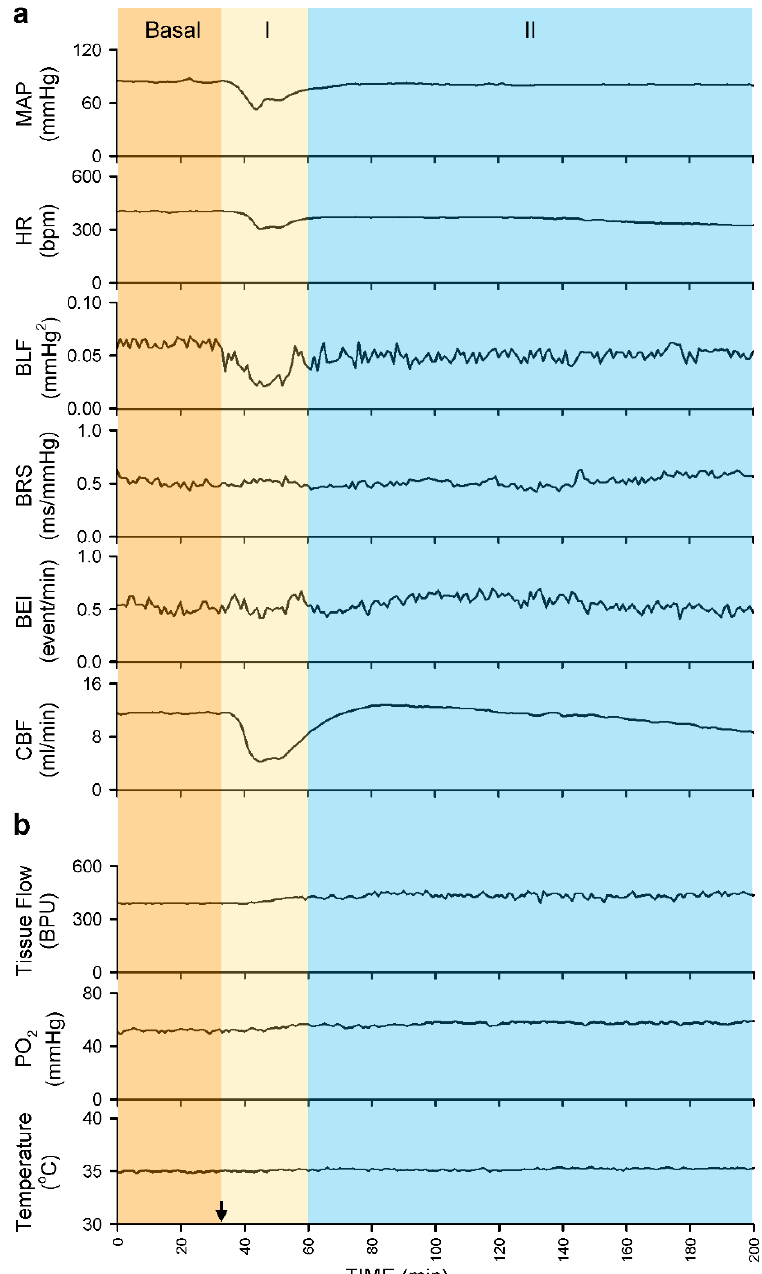
Figure 3. Illustrative examples of real-time and online recording of common phasic changes in mean arterial pressure (MAP), heart rate (HR), power density of the low-frequency component in systolic blood pressure spectrum (BLF), baroreflex sensitivity (BRS) or baroreflex effectiveness index (BEI), simultaneous with carotid blood flow (CBF) in Group 2 animals ( a ); or concurrent with tissue perfusion (Tissue Flow), tissue oxygen tension (PO 2 ) or tissue temperature in the cerebral cortex in Group 3 animals ( b ) on intrathecal administration of 80 μL of bupivacaine (at arrow).